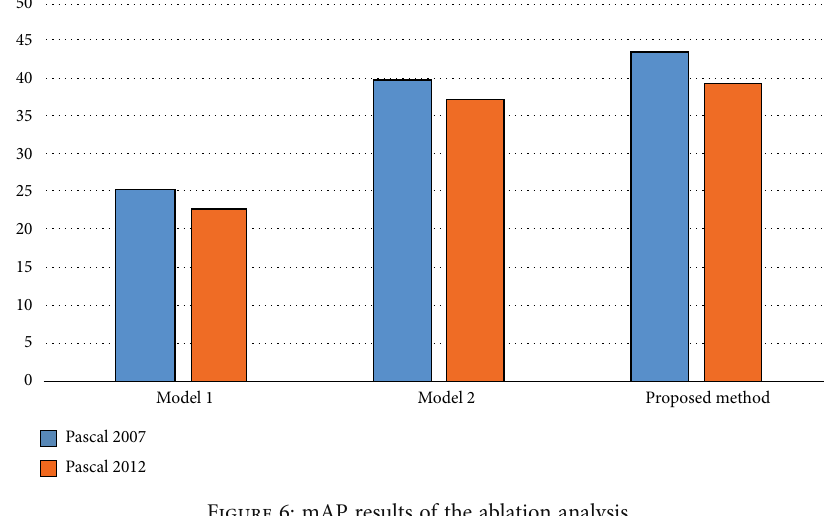
Figure 6: mAP results of the ablation analysis.